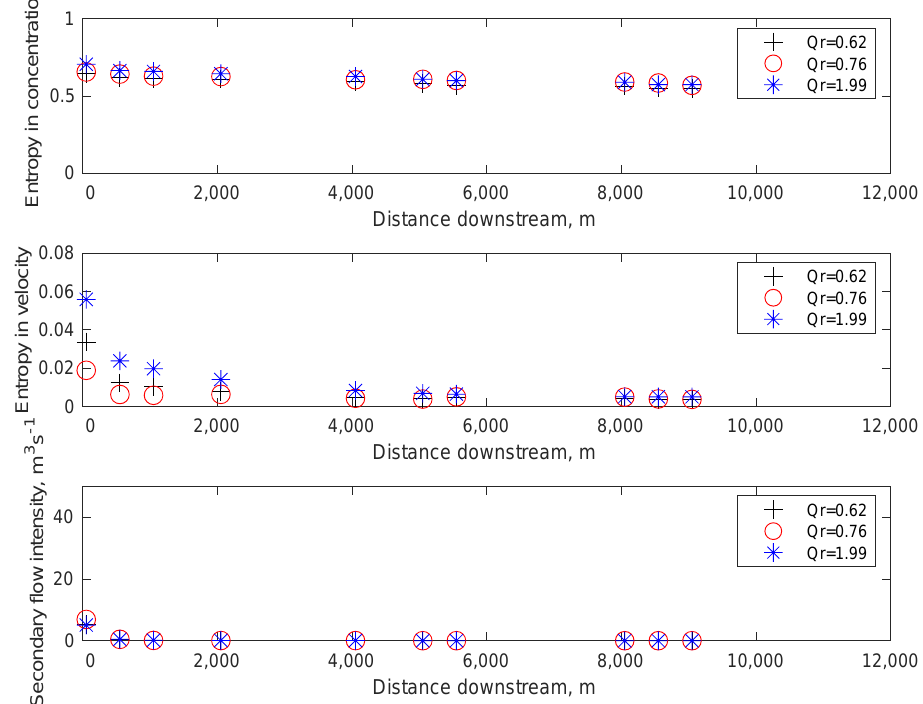
Figure 6. Longitudinal distribution of entropy of concentration, entropy of velocity, and secondary flow intensity for di ff erent values of the discharge ratio for the R simulations.